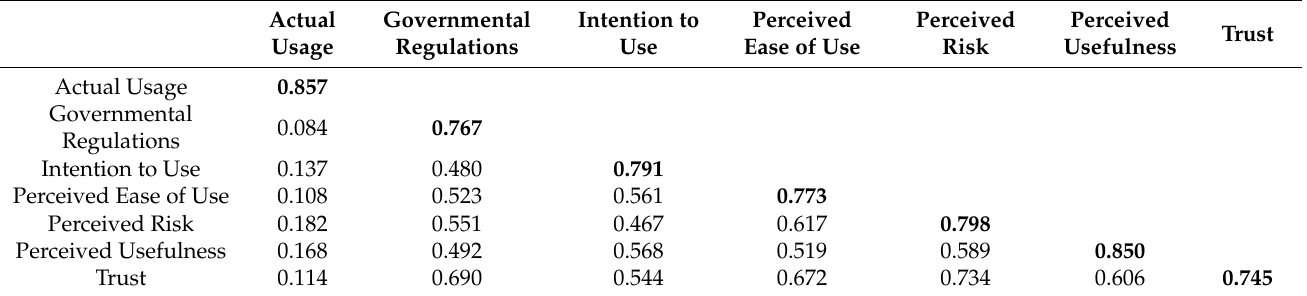
Table 3. Discriminant Validity (Fornell-Larcker Criterion).